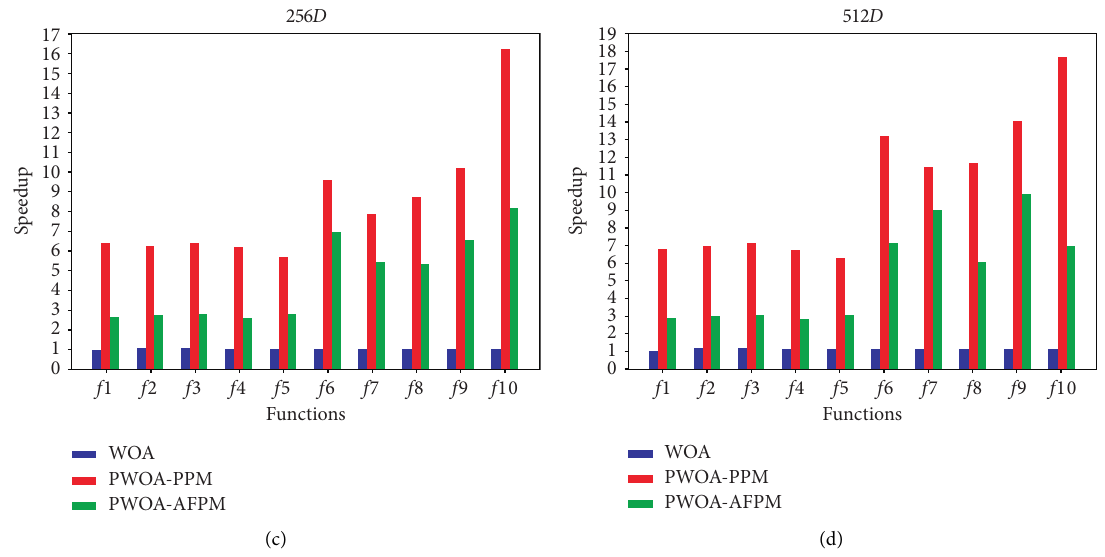
Figure 8: Comparison for the speedup between PWOA-PPM and